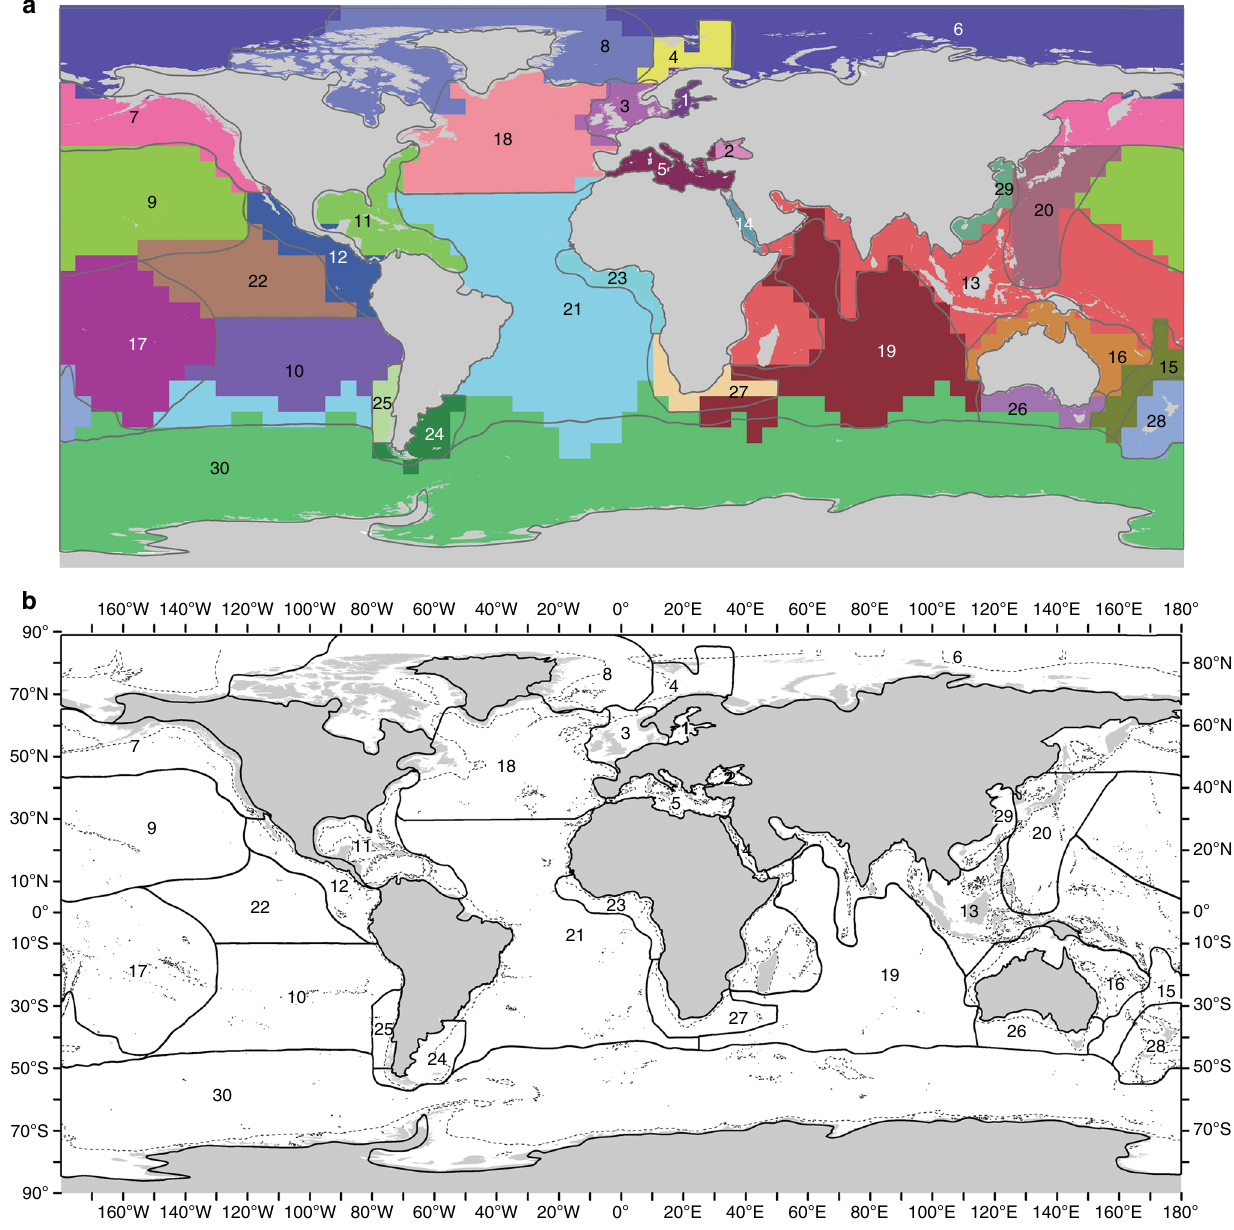
Fig. 2 The biogeographic realms as numbered 1 – 30 in Fig. 1. a Shows realms (denoted by solid lines) overlaid on the original 5 o latitude-longitude cells. Realm boundary smoothing included following the Southern Ocean 10 o C annual average sea surface temperature sub-Antarctic Front. b Shows the 1000 m depth contour as a dashed